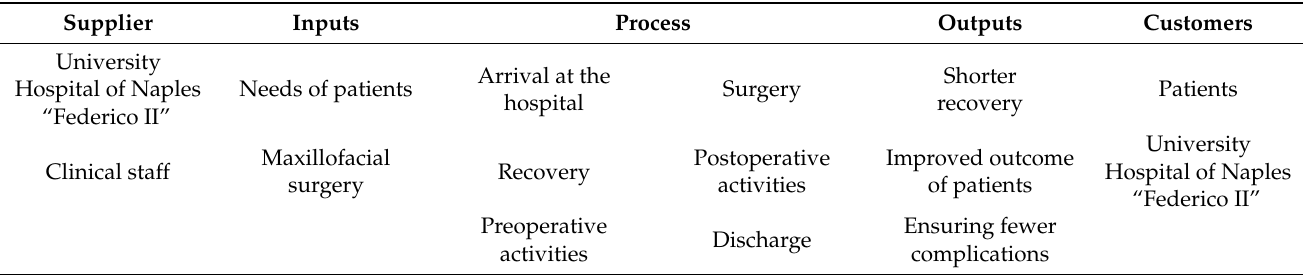
Figure 1. Project charter regarding the main aspects of the research. Table 1. SIPOC